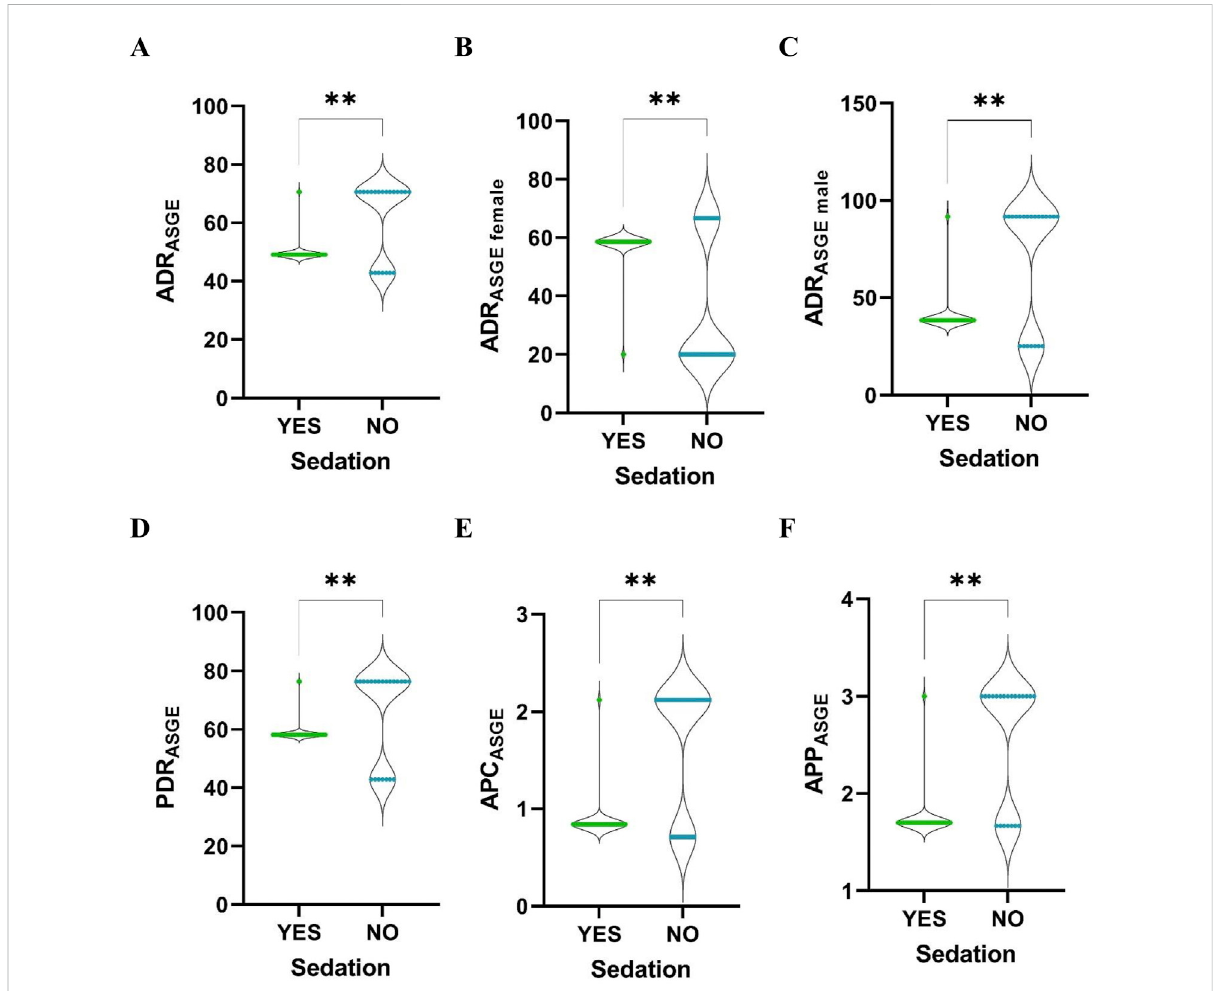
FIGURE 5 Comparison between sedated and non-sedated patients. (A) , ADR; (B) , ADR for female; (C) , ADR for male; (D) , PDR; (E) , APC; (F) , APP. **, p- value <